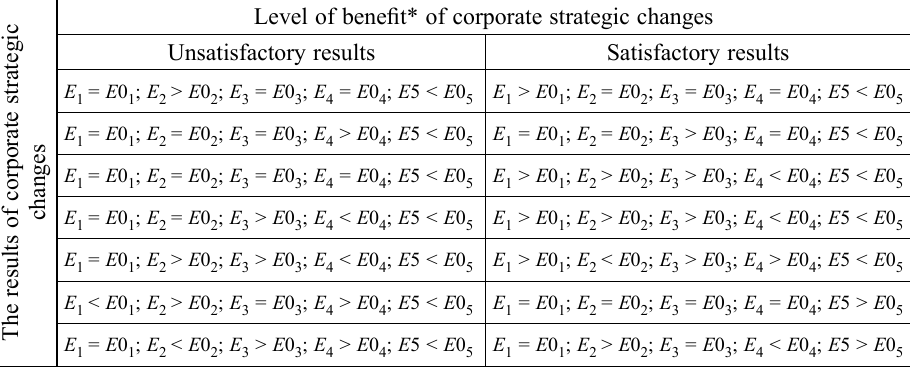
Table 1. Classification of results achieved due to corporate strategic changes